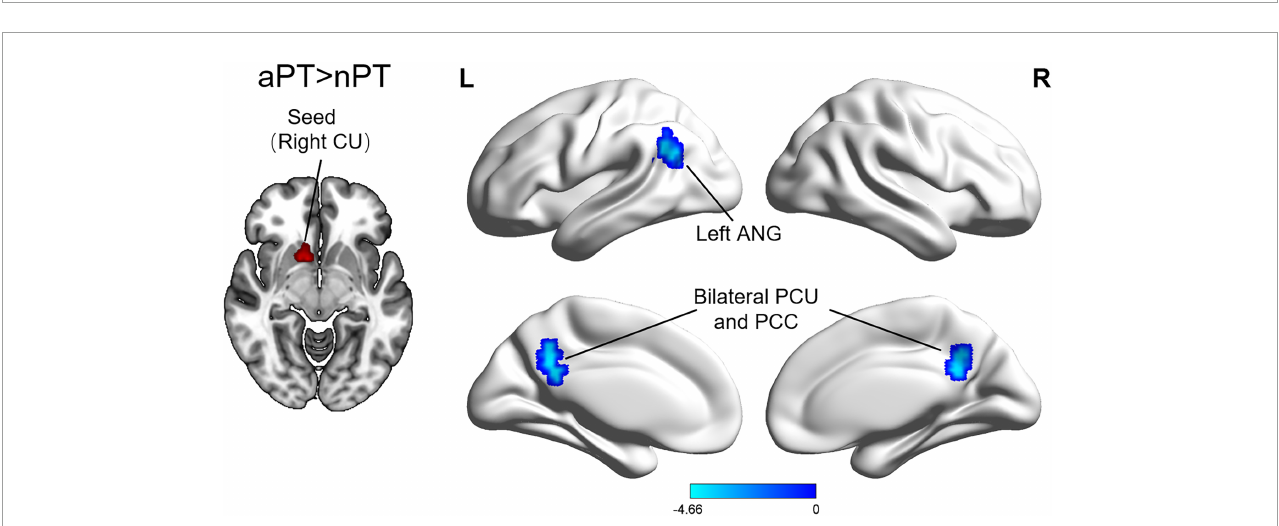
FIGURE2 Differences of functional connectivity between the nPT and aPT. Compared with nPT, aPT exhibited increased caudate nucleus connectivity to several brain regions: the left angular gyrus, bilateral precuneus, and bilateral posterior cingulate cortex. nPT, normal gait patients; aPT, abnormal gait patients; CU, caudate nucleus; ANG, angular gyrus; PCU, precuneus; PCC, posterior cingulate